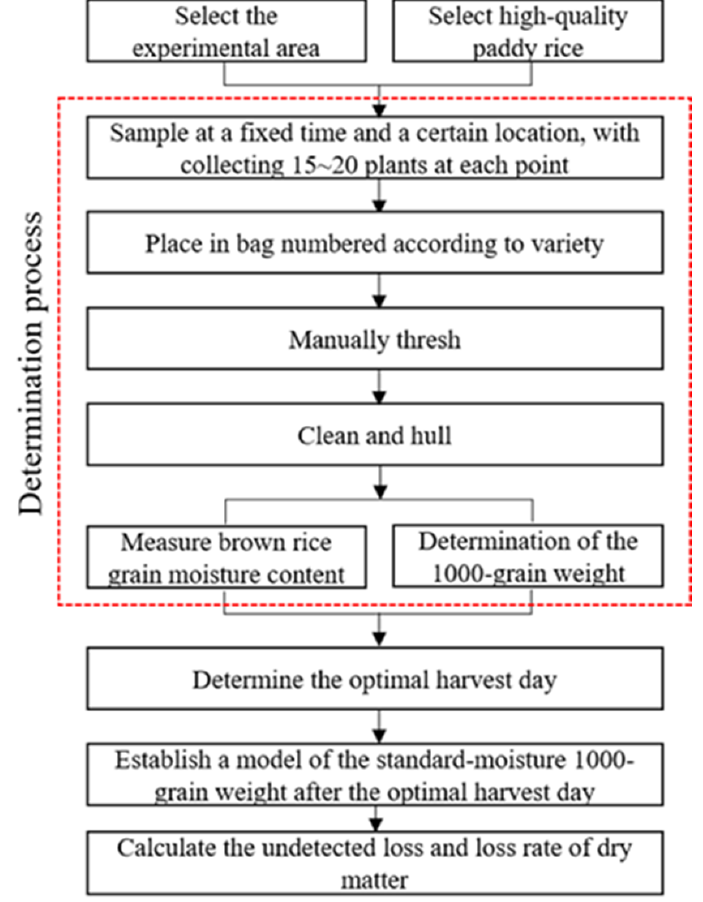
Figure 1. Experimental